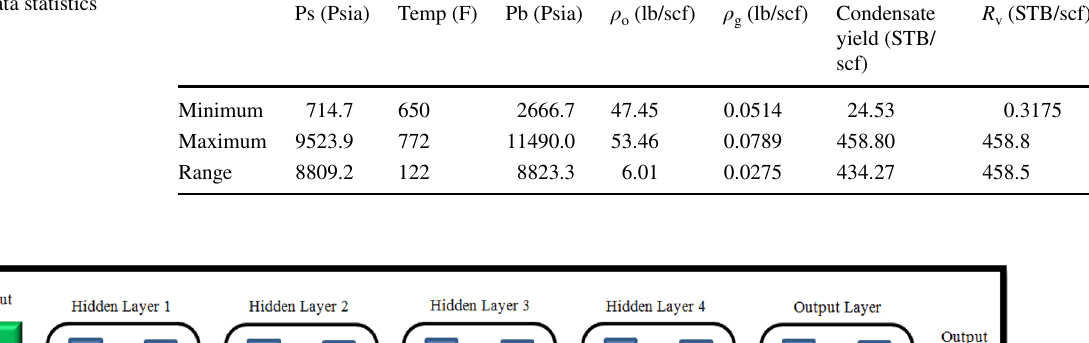
Table 2 Input data statistics